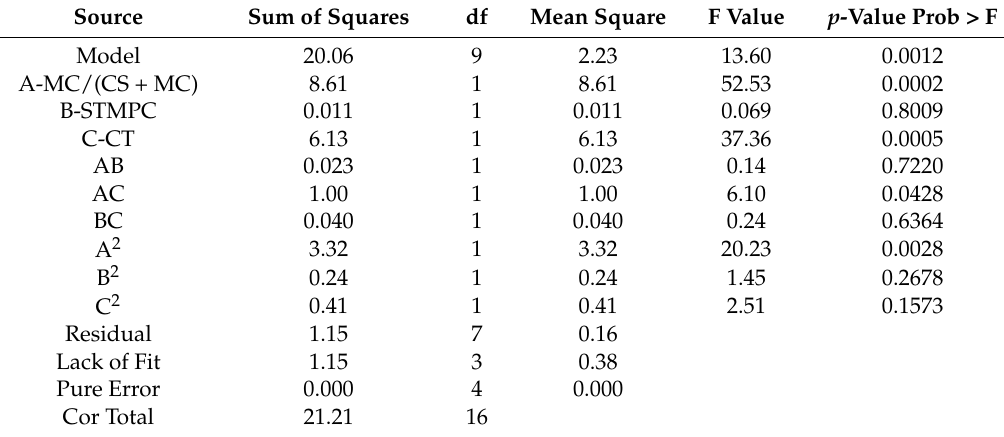
Table 2. Analysis of variance.